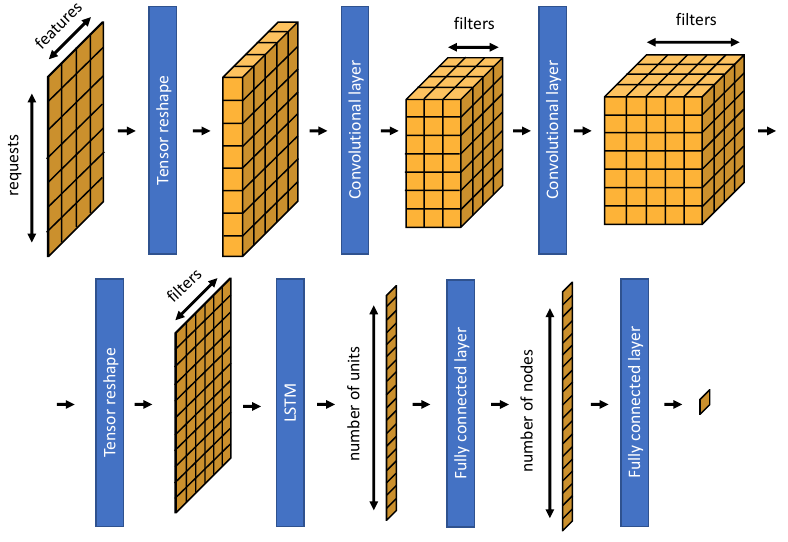
Figure 6. Exemplary visualization of the deep learning